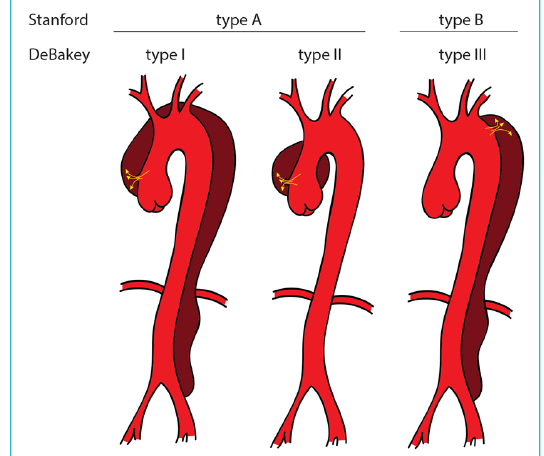
Figure 1: Classification of aortic dissection according to Stanford and DeBakey (drawn by J.